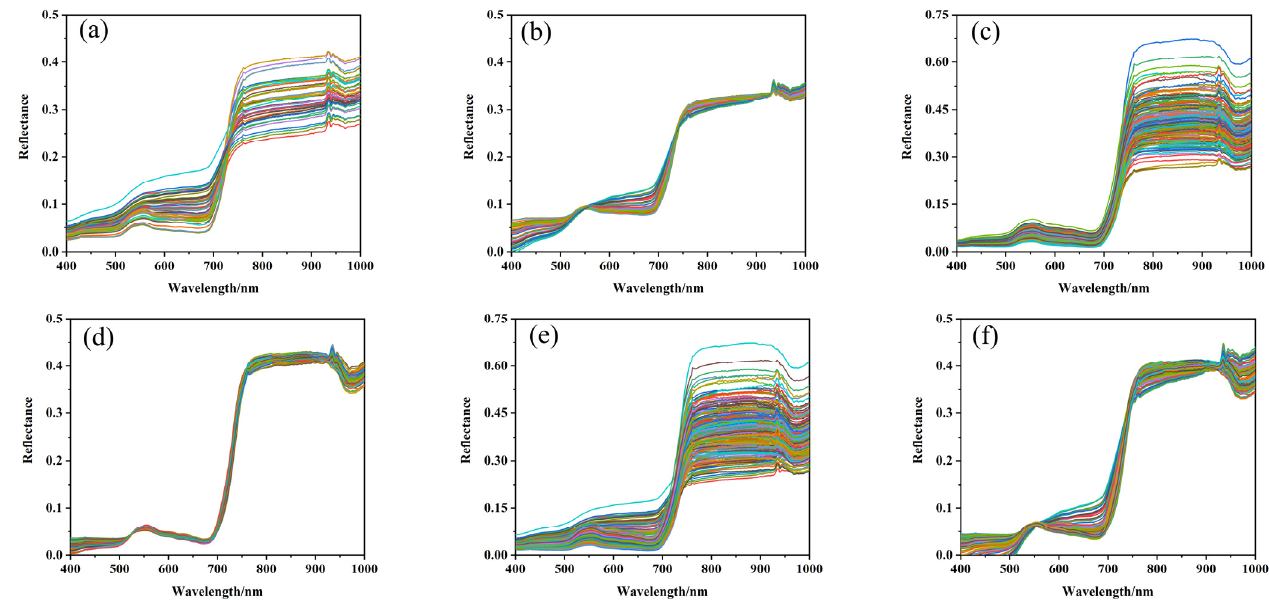
Figure 4. Re fl ectance spectra of the winter wheat canopy at di ff erent growth stages. Omni-spectral data in ( a ) the seedling stage, ( b ) the post-seedling stage, and ( c ) all stages, as well as pre-spectrum data in ( d ) the seedling stage, ( e ) post-seedling stage, and ( f ) all stages.